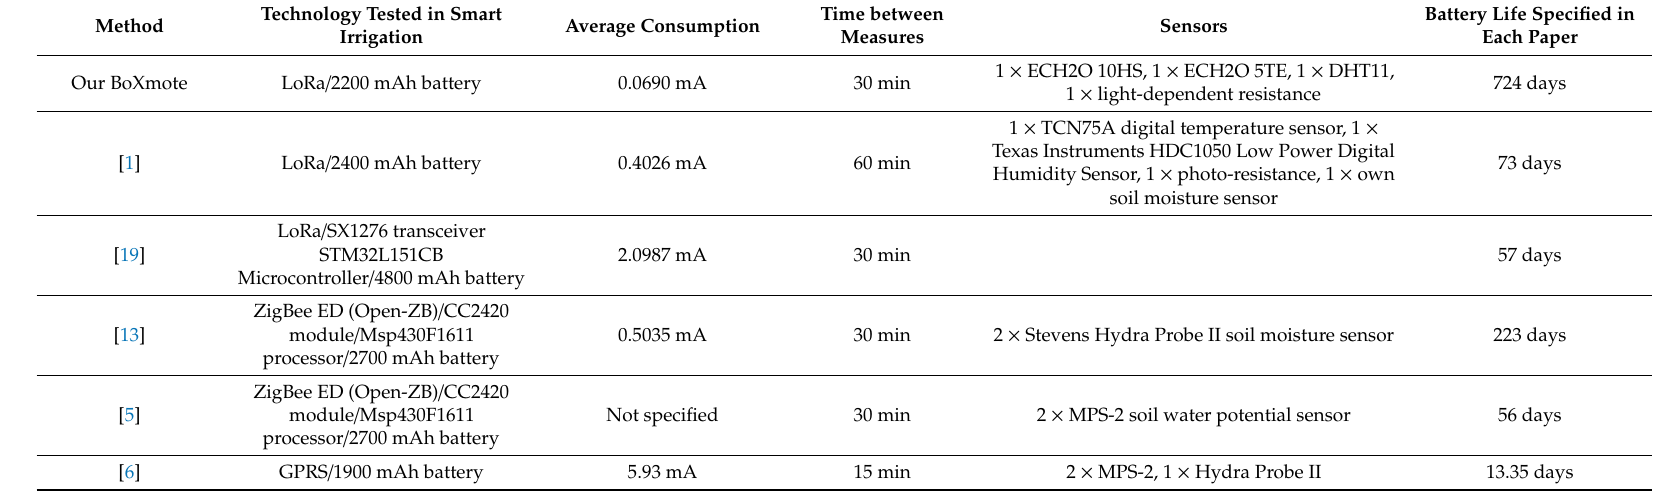
Table 4. Comparison of data obtained with other